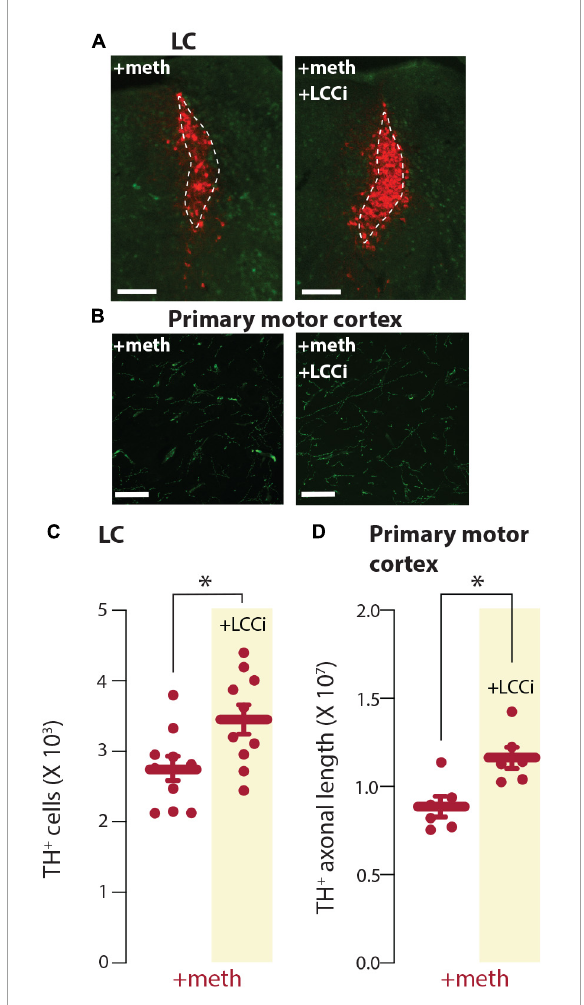
FIGURE6 L-type Ca 2 + channel inhibition prevented chronic meth-induced degeneration of locus coeruleus (LC) neurons. (A) Sample images depicting neuroprotection by the L-type Ca 2 + channel inhibitor isradipine (+LCCi; 3 mg/kg/day) to chronic meth (+meth; 5 mg/kg)-induced LC neuron loss; scale bars denote 200 µ m; TH stained in red with NeuN counterstained in green. (B) Sample images depicting neuroprotection by the L-type Ca 2 + channel inhibitor isradipine (+LCCi; 3 mg/kg/day) to chronic meth (+meth; 5 mg/kg)-induced LC axon loss; axons in the primary motor cortex were stained for NET; scale bars 20 µ m. (C) Stereological quantification of TH + cells indicated the loss of TH + cells in LC of chronic meth-treated mice was prevented by +LCCi; +meth n = 10 and +LCCi n = 10 mice. Data analyzed using an unpaired t -test [ t ( 18 ) = 2.601, p = 0.0181, two-tailed]. (D) Stereological quantification of NET + axon length indicated the loss of NET + axons in the primary motor cortex of chronic meth treated mice was prevented by +LCCi; +meth n = 6 and +LCCi n = 6 mice. Data analyzed using an unpaired t -test [ t ( 10 ) = 3.334, p = 0.0076, two-tailed]; ∗ p <